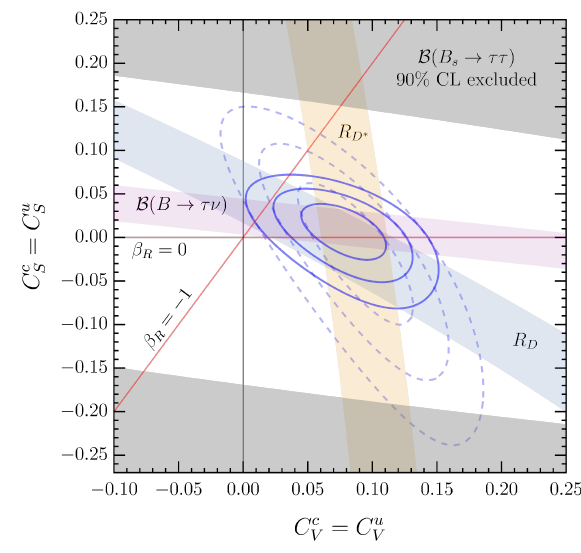
Figure 1. Best fit regions in the ( C c , C c ) plane. The three con- S V tours corresponds to 1, 2, and 3 σ intervals. The dashed blues lines take into account only the information from R D and R D ∗ (for which we use the HFLAV average [20]), whereas the con- tinuous lines also include constraints from b → u observables. The colored bands correspond to the 1 σ regions defined by each observable. The gray bands show the 90% CL exclusion region from B ( B s → τ ¯ τ ).